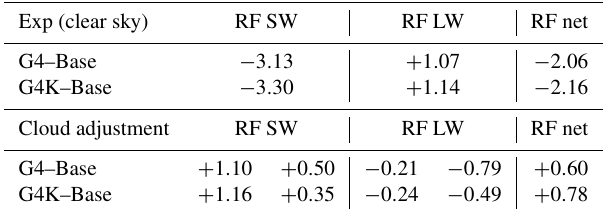
Figure 14. Zonally averaged cloud adjustments to the clear-sky SG aerosol RF (Wm − 2 ), as a function of latitude (time-averaged over the years 2030–2069). See legends for line meaning. The positive adjustment due to (passive) background clouds (black solid line for G4, black dashed line for G4K) shows the net value (SW+LW), which is largely controlled by the SW contribution (see Table 4 and Fig. S3). Table 4. Rearrangement of the results presented in Table 3, with the calculated cloud adjustments (bottom three rows) to clear-sky RF components (top three rows). The cloud adjustments for the SW and LW RF contributions are shown separately for the presence of background atmospheric clouds (left) and for cirrus thinning (right): the former is calculated as the difference between the all-sky and clear-sky aerosol RFs, with the all-sky including the background warm clouds and fixed UT ice